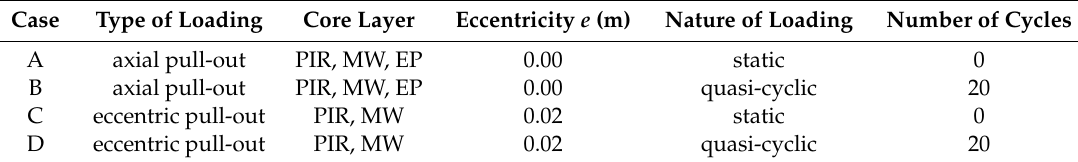
Table 4. Set of laboratory experiments.